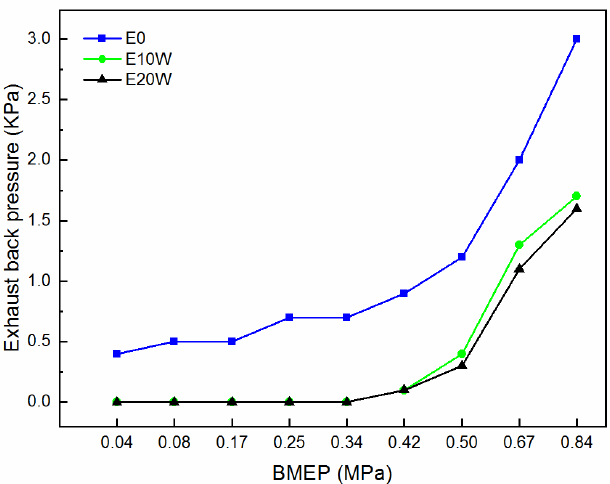
Figure 3. Exhaust back pressure of three fuels at various loads.